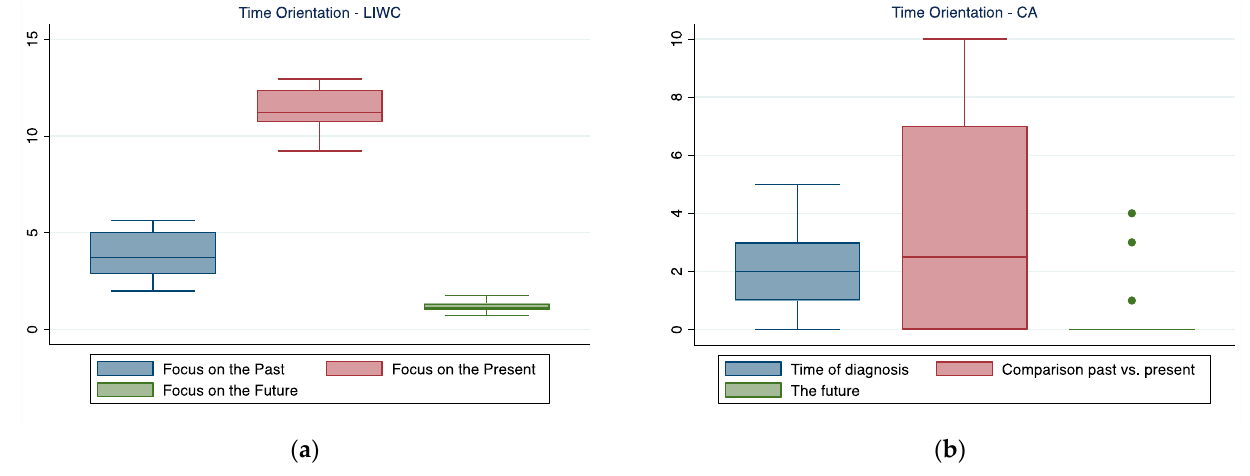
Figure 4. Time orientation emerged by LIWC ( a ) and CA ( b ). In the boxplot, the central horizontal line indicates the median, the other two lines indicate the first (lower line) and third (higher line) quartiles, the whiskers indicate the minimum and maximum values, and the dots indicate outliers.